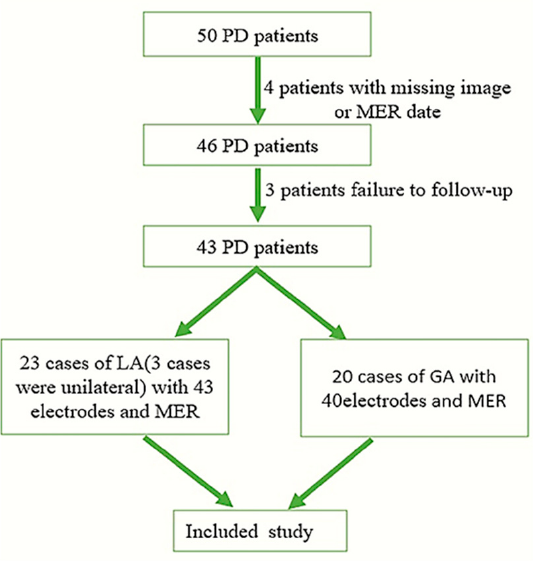
Figure 1. The patients screening procedure. PD, Parkinson’s disease; MER, microelectrode recording; and STN, subthalamic nucleus.